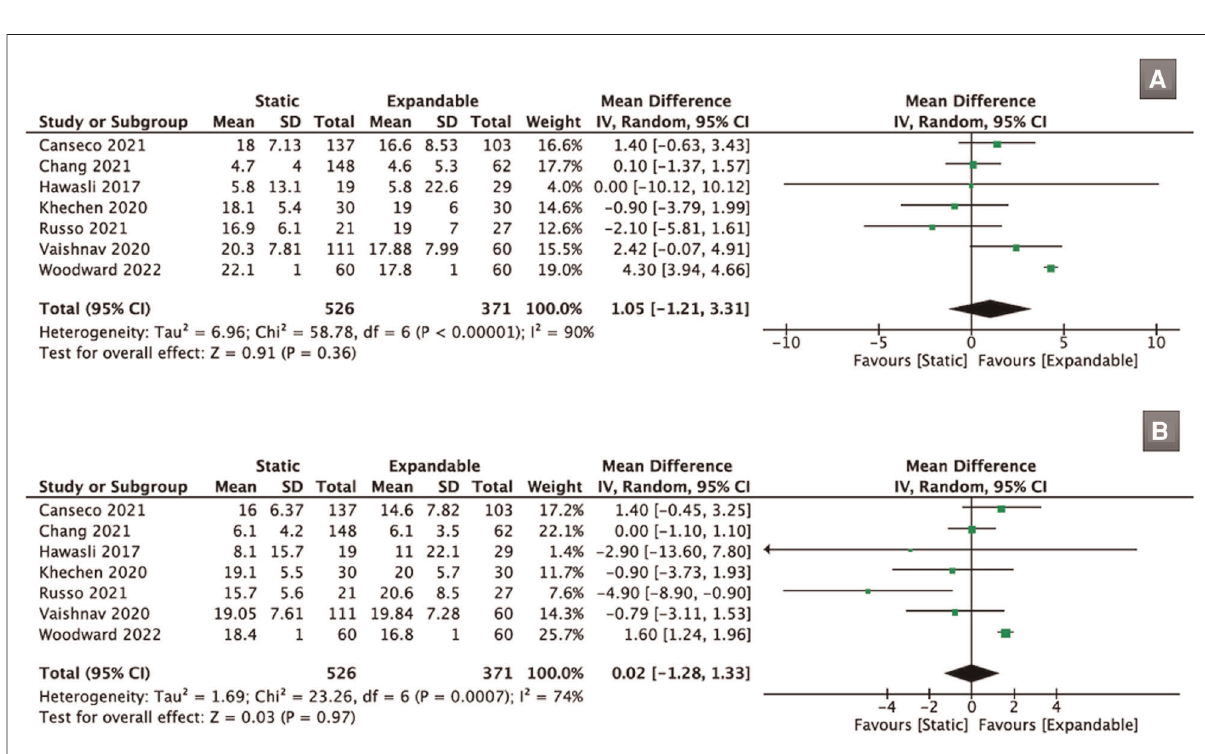
FIGURE 4 Forest plots for comparison of SL at preoperative ( A ) and fi nal follow-up ( B ) between the static and expandable groups. SL: segmental